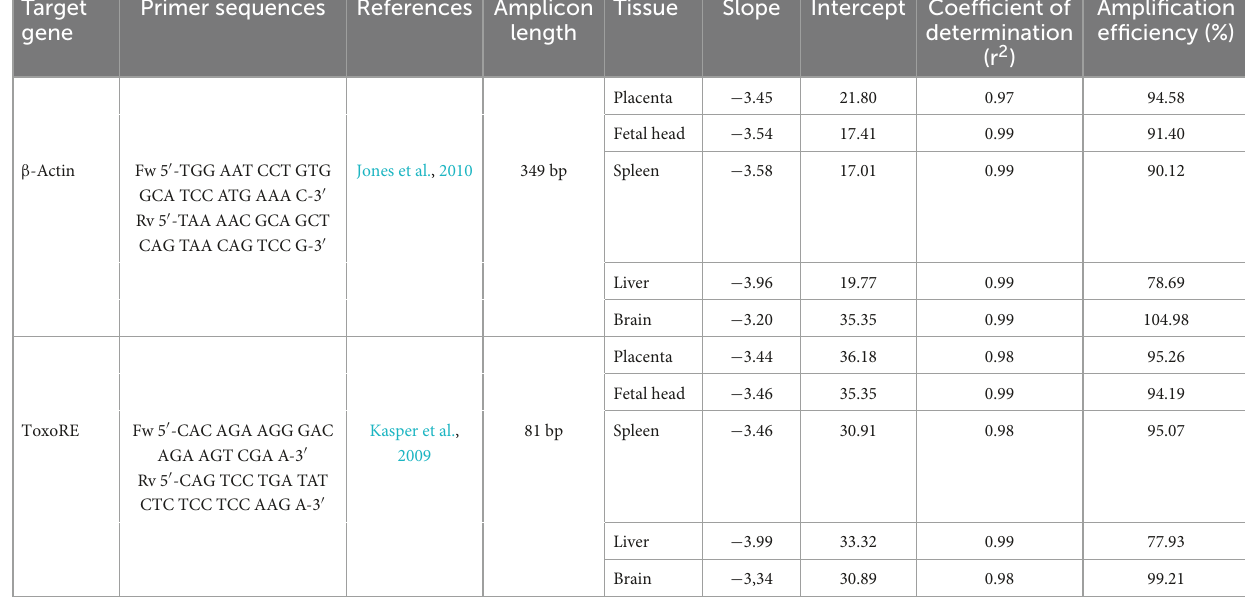
TABLE 1 Primers and standard curve parameters for determination of parasite load in mice infected with Toxoplasma gondii . Target